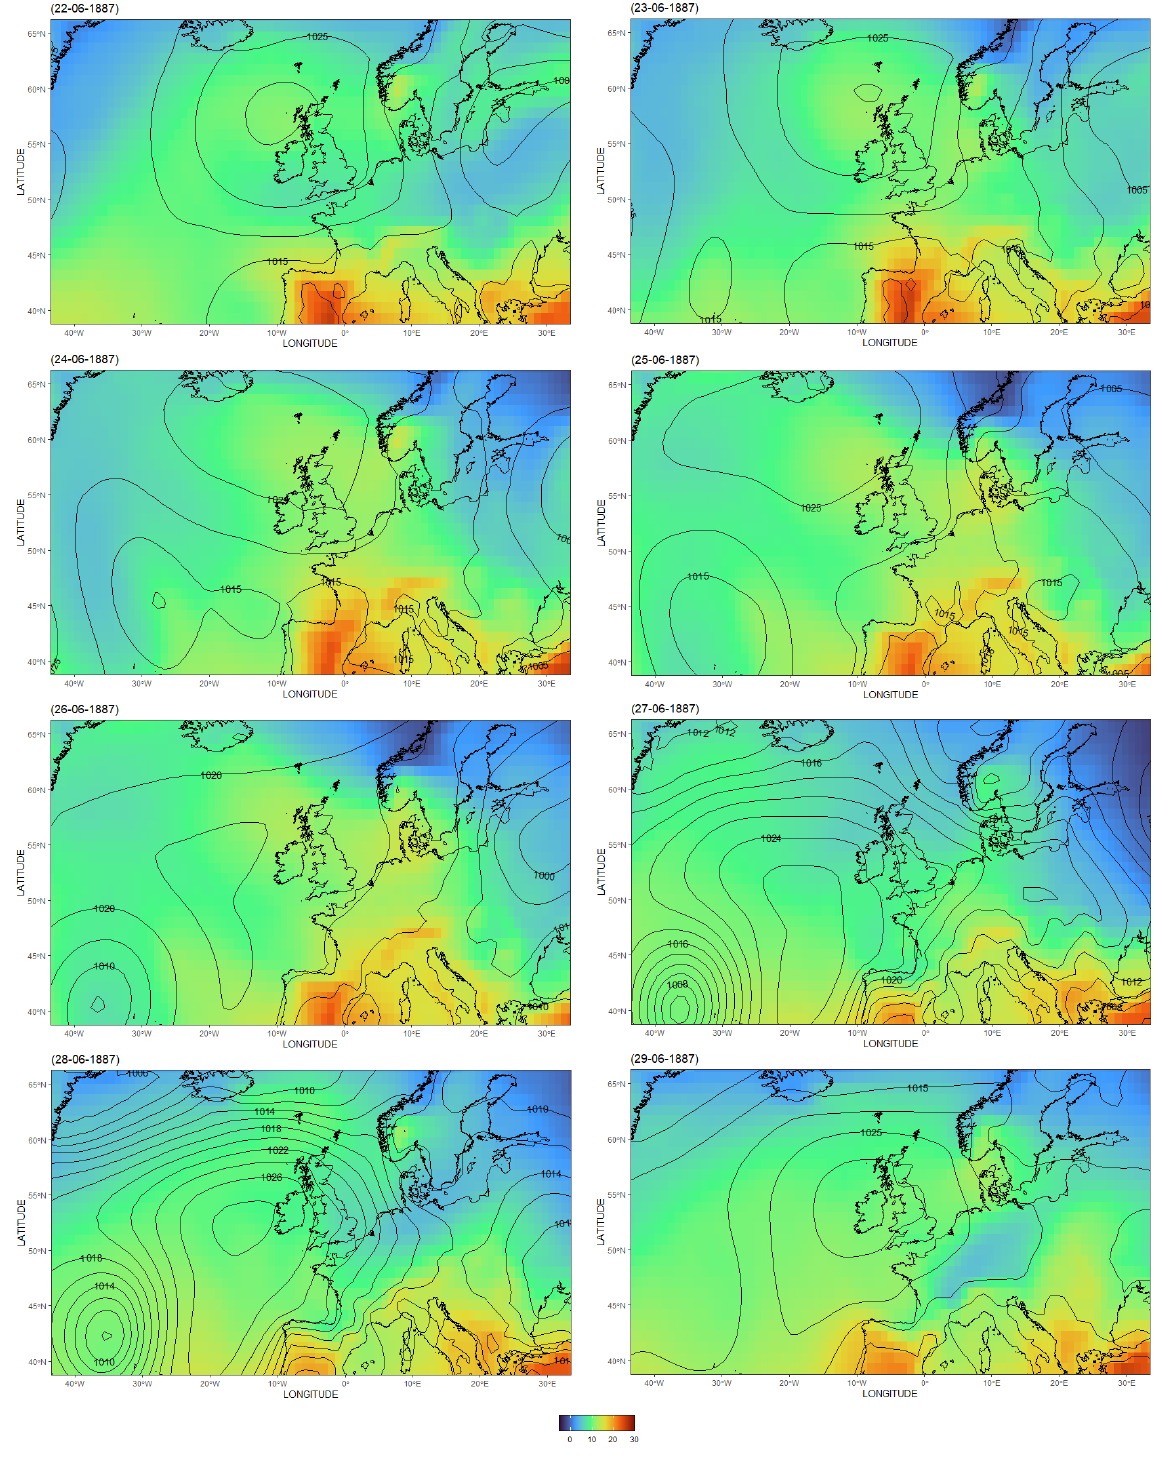
Figure 4. NOAA 20CRv3 MSLP and 850hPa temperatures over an 8d period centred upon 26 June 1887. The 20th Century Reanalysis V3 data provided by the NOAA/OAR/ESRL PSL, Boulder, Colorado, USA, from their web site at https://psl.noaa.gov/data/gridded/data.20thC_ ReanV3.html (last access: 21 January 2022; NOAA PSL, 2020). The domain of latitude 35–70 ◦ N and longitude 45 ◦ W–30 ◦ E was chosen to provide a synoptic view, with Ireland centred to provide an overview of the surrounding regions. The 850hPa temperatures are given in colours while MSLP is given as contours. All maps correspond to 15:00UTC, which is the approximate expected time of daily maxima in Ireland (corresponding to ca.